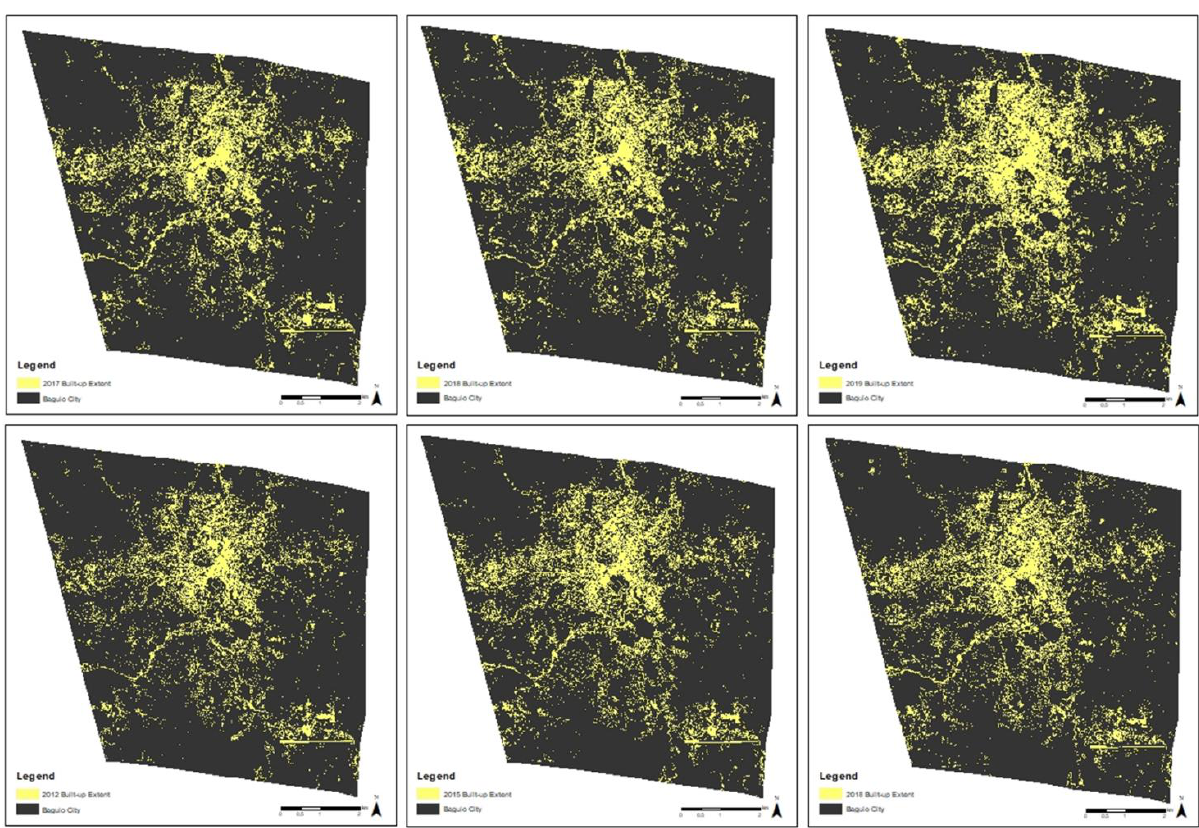
Figure 5. Yearly PlanetScope (2017, 2018 and 2019, top) and RapidEye (2012, 2015 and 2018) built-up maps of Baguio City generated using the visible green based built-up index (VgNIR-BI) derived from the green and NIR bands of the two satellite data